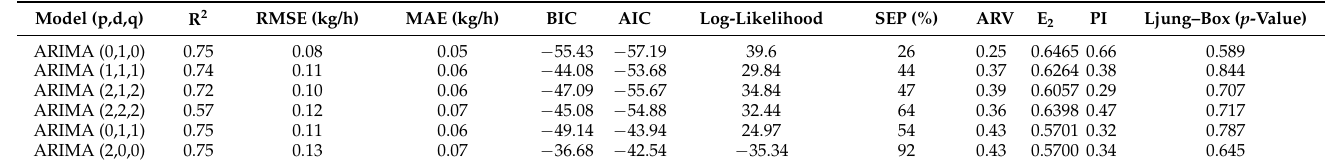
R 2 means coefficient of determination, RMSE means square root of the mean square error, MAE means mean absolute error, BIC means Bayesian information criterion, AIC means Akaike information criterion, SEP means percentage standard error of prediction, ARV means average relative variance, E 2 means efficiency Coefficient, PI means persistent